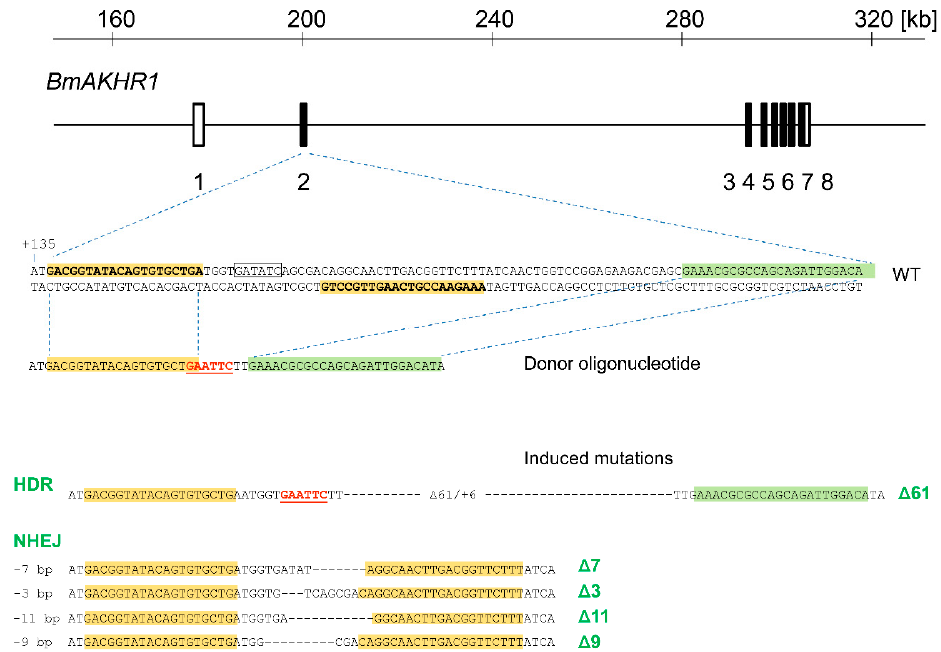
Figure 3. Mutagenesis of BmAKHR1 using TALENs. Positions of TALEN target in the BmAKHR1 gene; rectangles and numbers below represent exons. The numbers at the top of the panel indicate distances in kb. The sequence below the line indicates part of the second exon (WT) together with a donor oligonucleotide used for co-injection. The left and right TALEN binding sites are highlighted in yellow. Eco RV restriction site in wt sequence is boxed; Eco RI restriction site in the donor oligonucleotide is highlighted in red and underlined. Donor contains a 20 nt left arm homologous to the flanking sequence of the cleavage site and a 25 nt right arm (highlighted in green) homologous to the genomic sequence shifted downstream of the cleavage site, thus skipping the entire recognition site of right TALEN monomer. Sequences at the bottom indicate examples of induced mutations including HDR (a product of homology-directed repair) and several NHEJ (non-homologous end joining) events. Deletions in the sequence alignments are represented by dashes. The lengths of deletions are indicated to the left of the sequences, allele symbols to the right (green